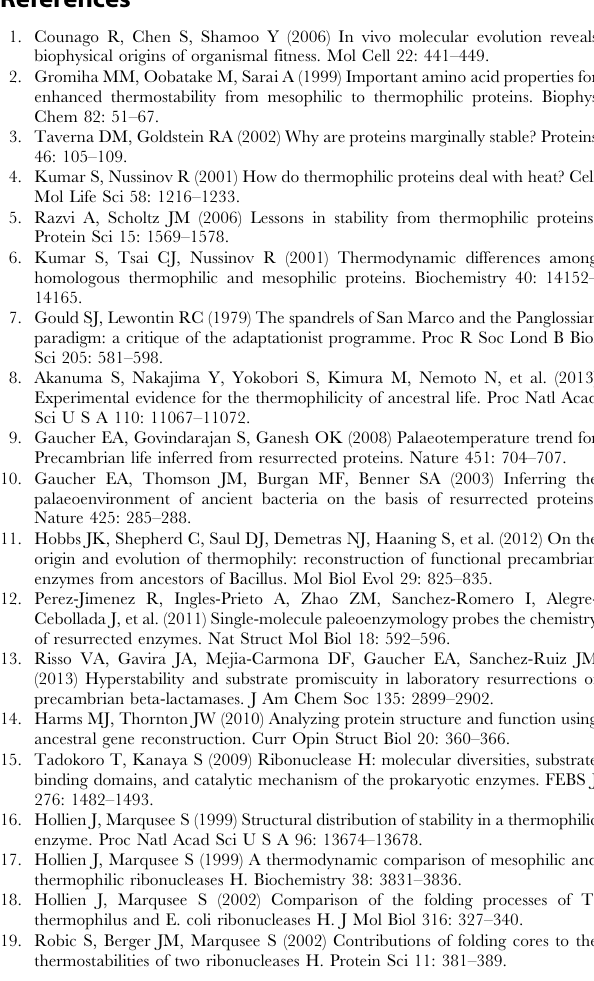
Table S3 Data collection and refinement statistics for AncC. * Values in parentheses are for highest-resolution shell. Table S4 D G s and m -values at 25 6 C. *Errors reported are standard deviations from replicate experiments. Table S5 Thermodynamic parameters from stability curve fits. * Errors from fit. { Extracted from thermal melt fit. { Extracted from stability curve fit. Table S6 Individual proteins populate discrete regions of parameter space. (DOCX) Dataset S1 RNH sequence alignment. Dataset S2 Numerical data underlying main text and supplemental